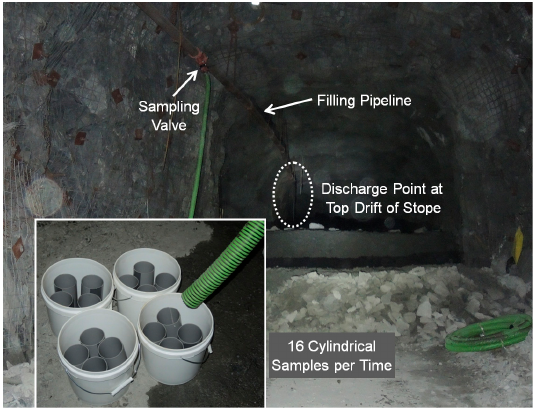
Figure 3. The sampling method and device used at the overcut of stopes being filled.